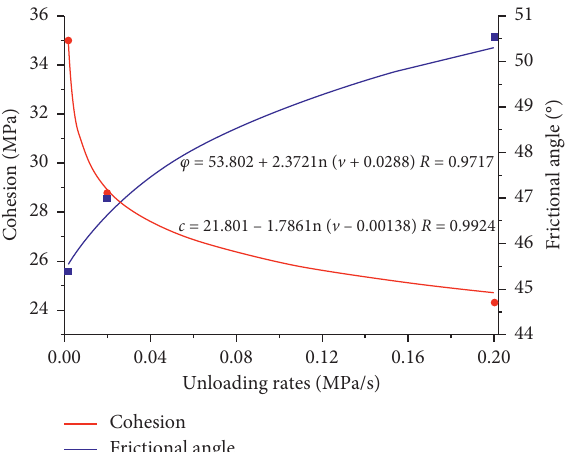
Figure 10: Cohesion and friction angle of granite under different unloading